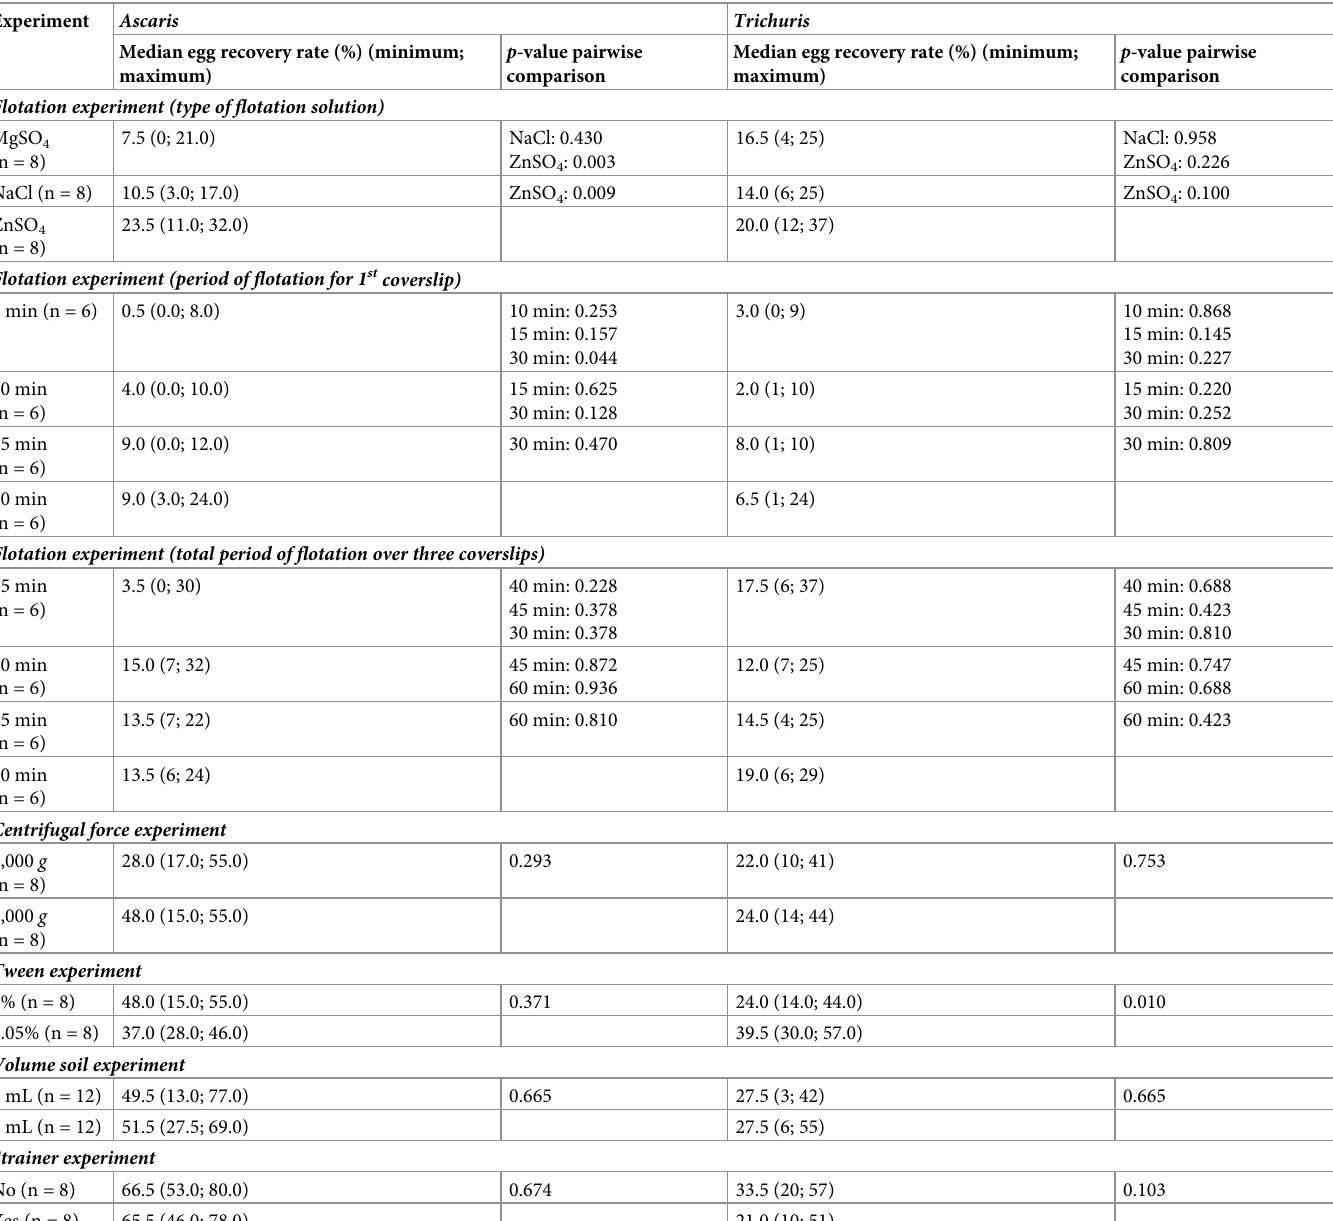
Table 1. The egg recovery rate for Ascaris and Trichuris across five experiments. The p -values were based on a non-parametric test (Wilcoxon rank sum test).